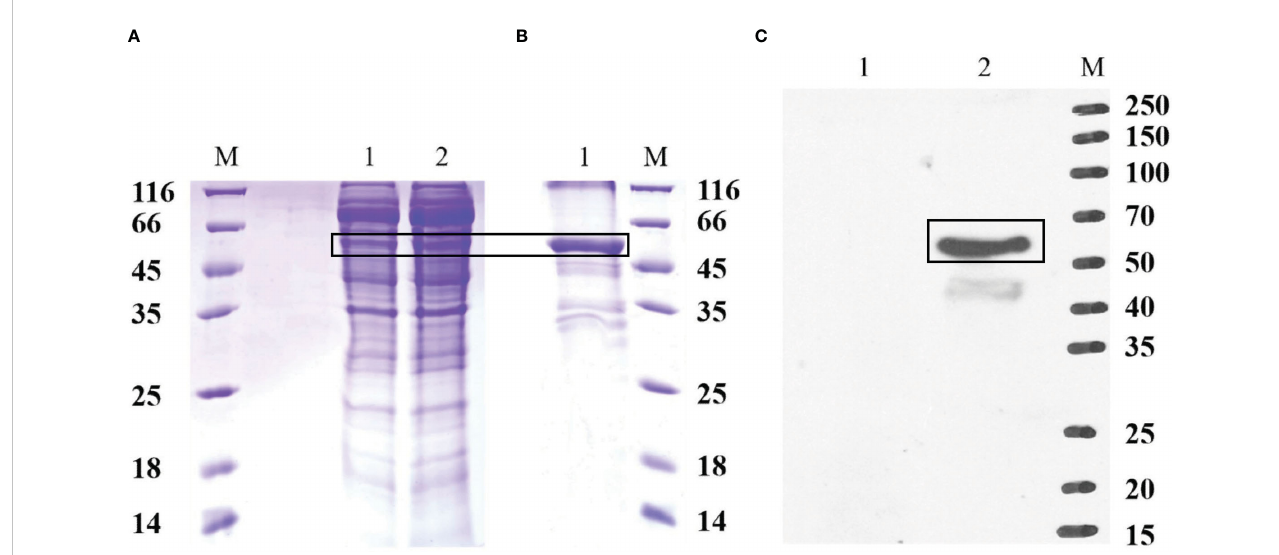
FIGURE 3 Production of recombinant EccGAS and anti-EccGAS serum. (A) Expression of recombinant EccGAS. M: protein molecular quality standard; 1: supernatant of pET-EccGAS induced by sonication; 2: microspheres of pET-EccGAS induced by sonication. (B) Puri fi cation of recombinant EccGAS. M: protein molecular quality standard; 1:puri fi ed recombinant pET-EccGAS protein. (C) Preparation of anti-EccGAS serum. M: protein molecular quality standard; 1: puri fi ed recombinant pET-EccGAS protein incubated with preimmune mouse serum; 2: puri fi ed recombinant pET-EccGAS protein incubated with anti-EccGAS serum (1:5000). Bands of EcCGA protein were boxed.